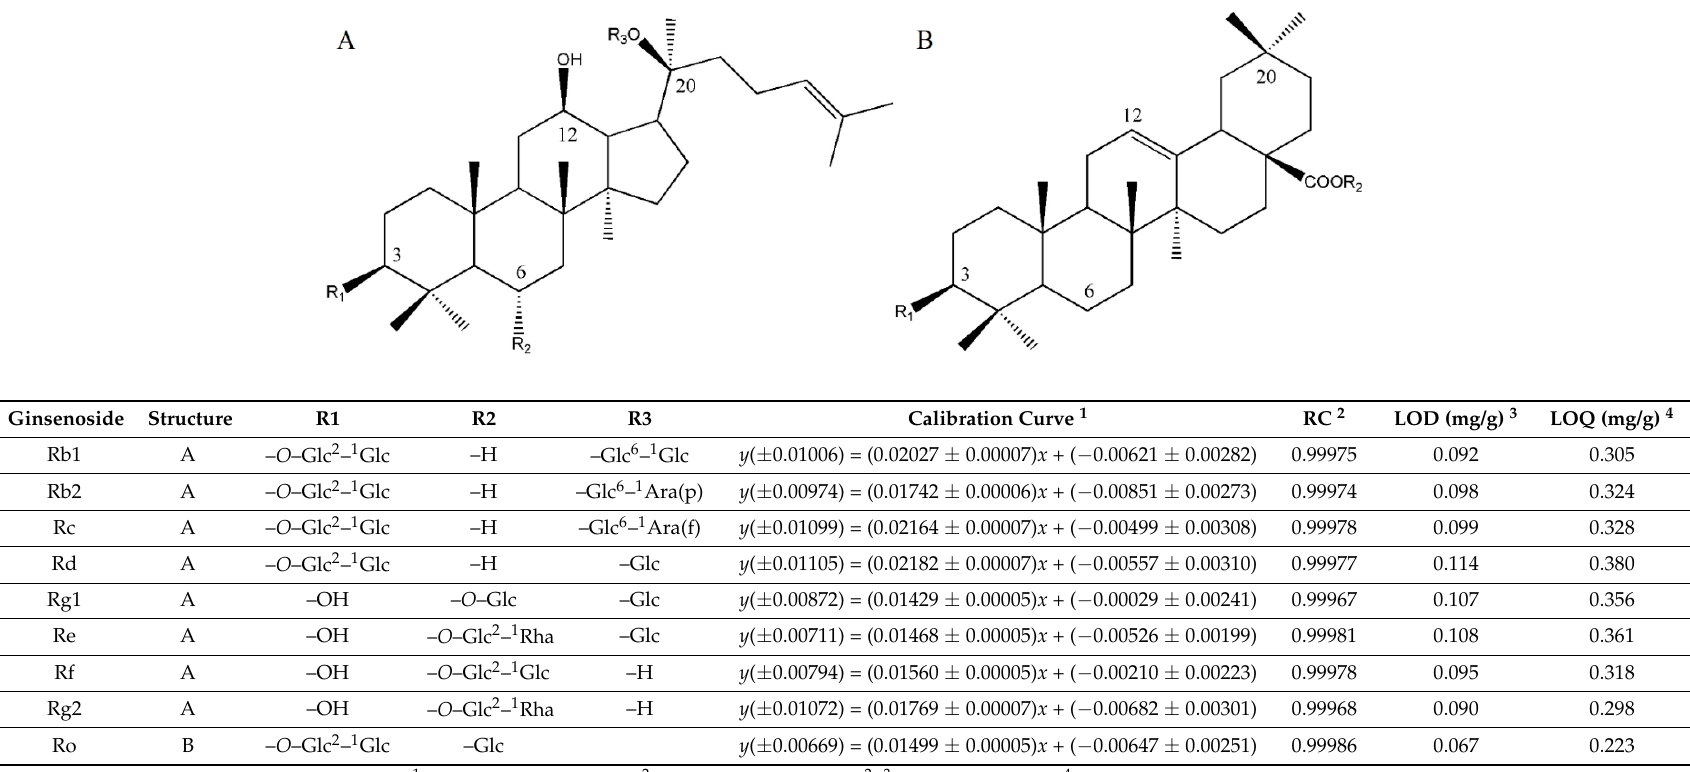
Table 1. Structure and calibration curves of nine ginsenosides studied in this study.